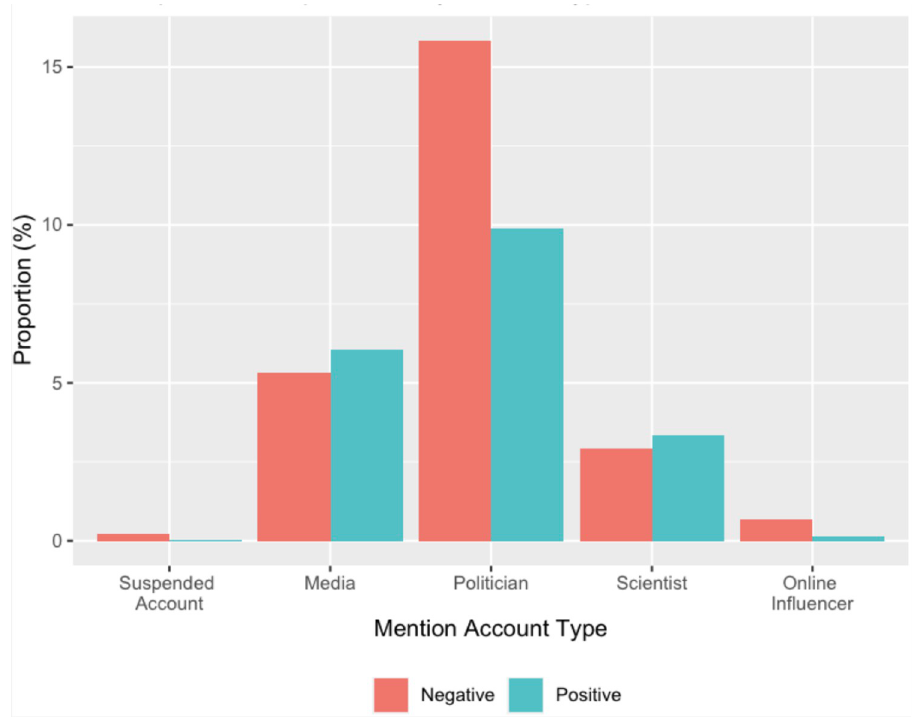
Fig 7. Proportion of the top mention by account type and discourse